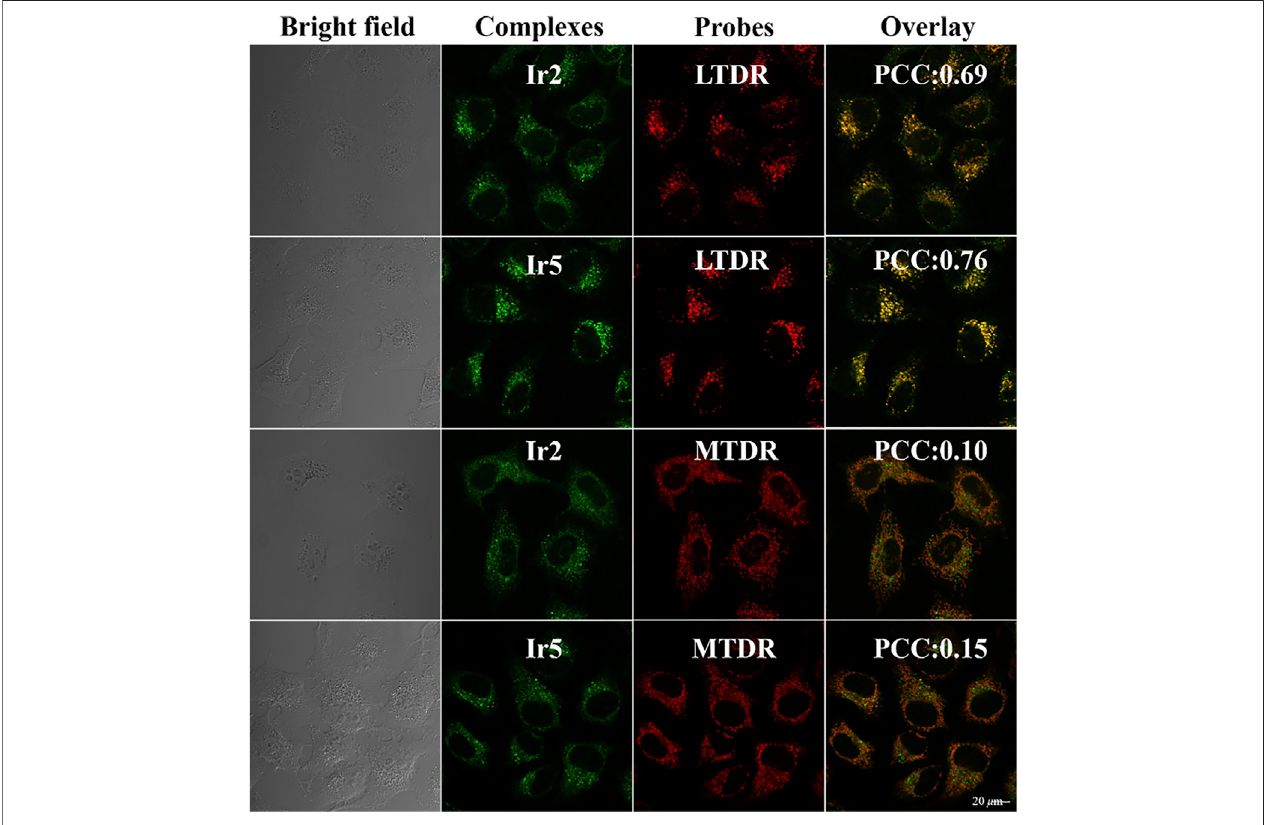
FIGURE4| ConfocalmicroscopyimagesofA549cellshatchededwithIr2orIr5(10.0 μ M,1 h),LTDR(75 nM,0.5 h)andMTDR(500 nM,0.5 h)at37 ° C(Ir2andIr5 excitation at 405 nm; Emission: 430 – 580 nm; LTRD and MTDR excitation at 594 and 644 nm; Emission: 630 ± 30 nm and 690 ± 30 nm).